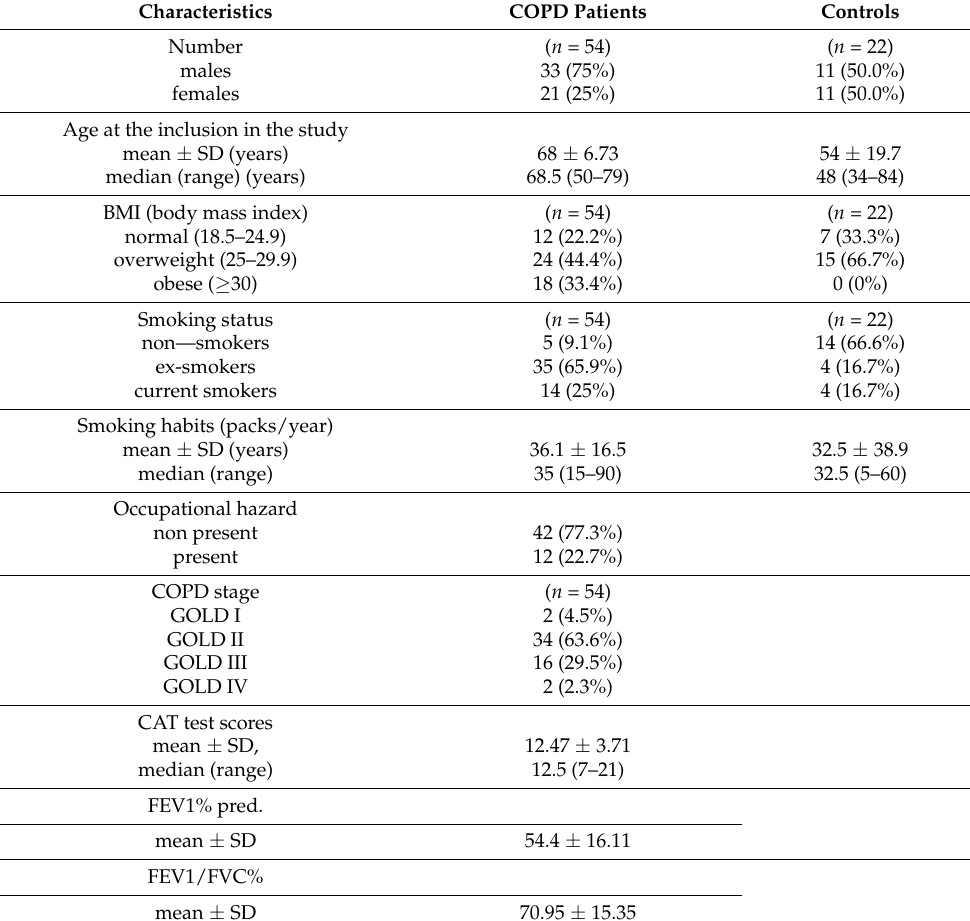
Table 1. Demographic and clinical data of COPD patients and